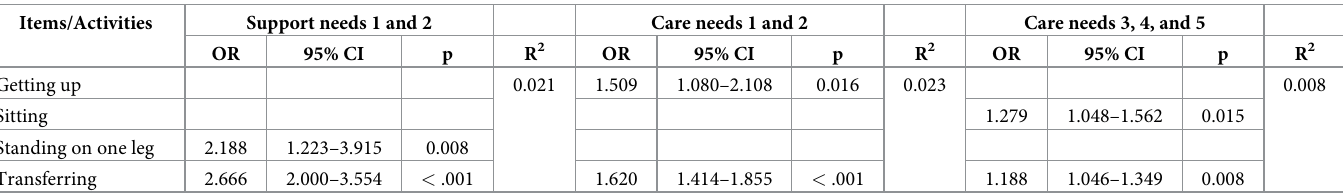
Table 2. Risk factors for nursing home placement related to basic